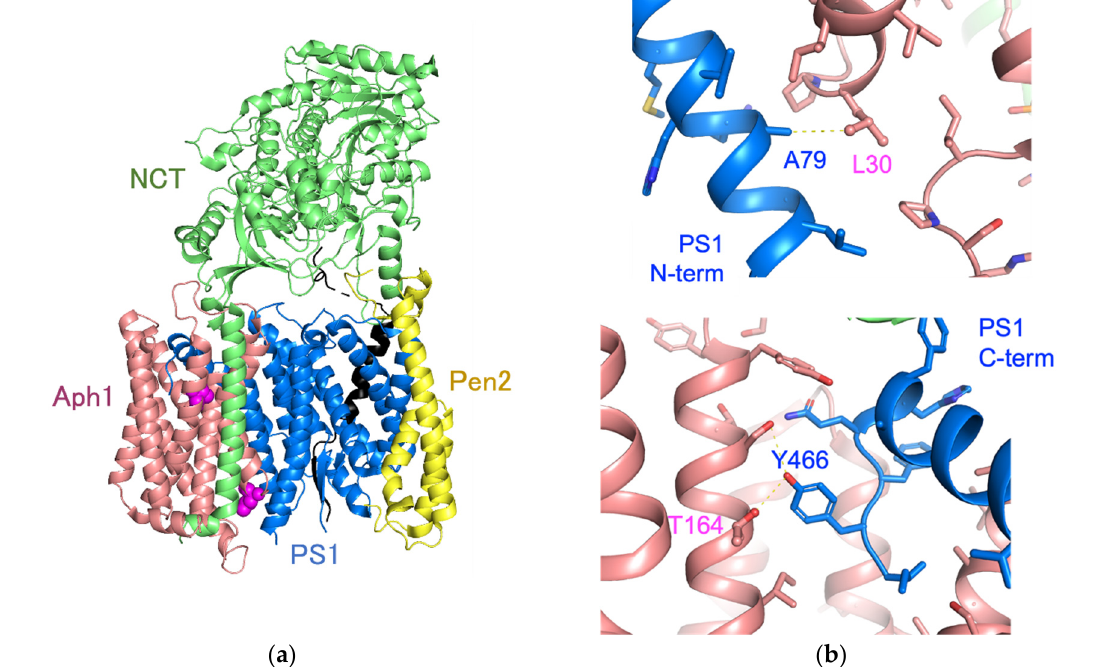
Figure 7. Aph1 mutations in the structure-based model. A structure-based model of the transmem- brane core of human γ -secretase (Protein Data Bank code 5A63) is shown with a sphere containing the following residues: Leu30 and Thr164 (purple), PS1 (blue), Aph1aL (pink), NCT (yellow-green), Pen2 (yellow), and APP (black) ( a ). Leu30 and Thr164 of Aph1 are in close proximity to Ala79 and Tyr466 of PS1, respectively ( b ).